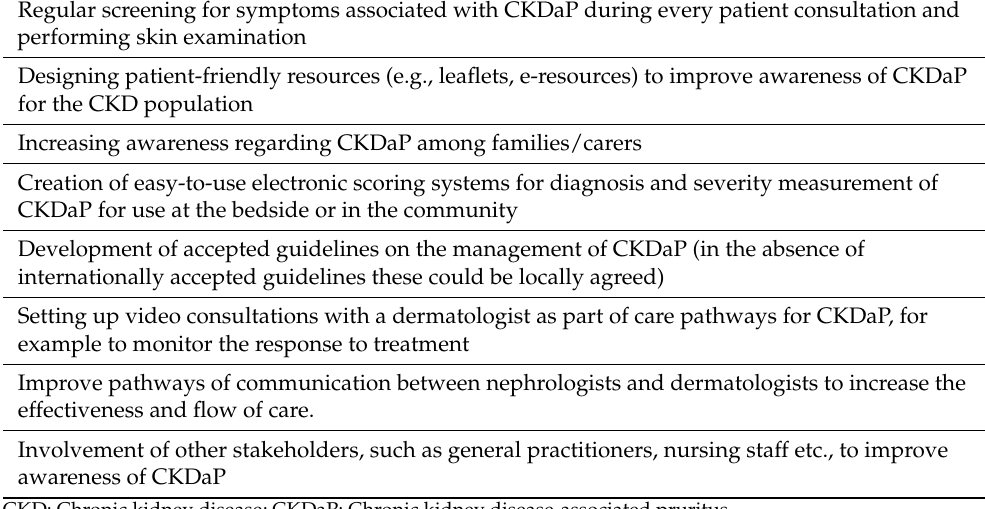
Table 2. Future directions for patient-centered care in